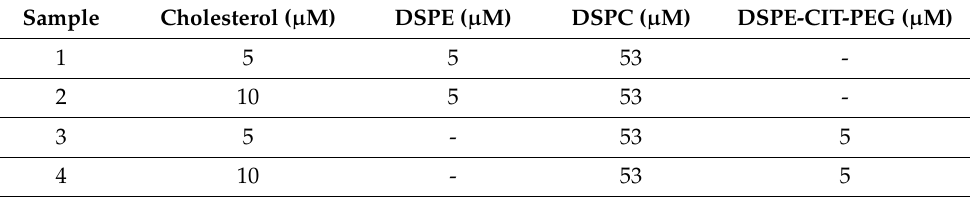
Table 1. The amounts of different components of the nano-liposomes. DSPE: